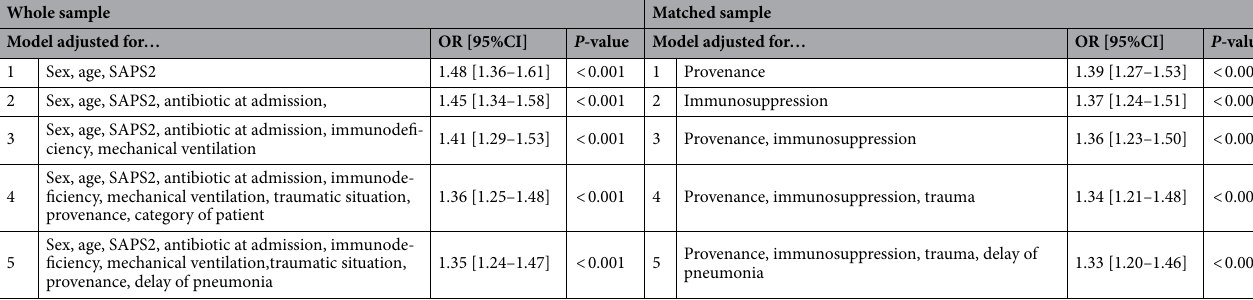
Table 4. Highly antimicrobial resistant status and ICU mortality (variate analysis). SAPS2 simplified acute physiology score.